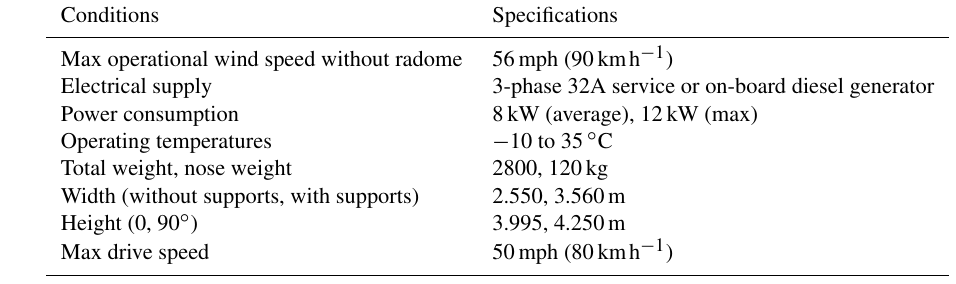
Table 3. Operational conditions and logistical requirements of the NXPol.